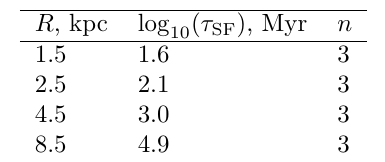
Table 3. The parameters of 1-D